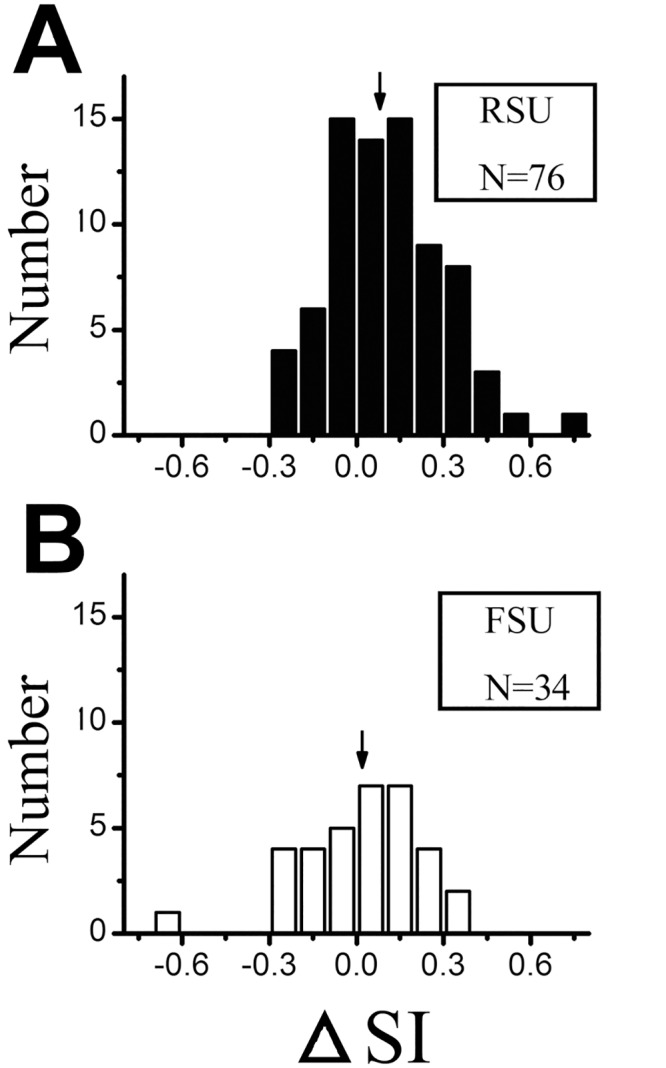
The histogram of changes in strength of surround suppression for FSUs and RSUs.The △SI indicate the difference between SIhigh and SIlow. The arrows indicate the average, which was 0.02 for FSUs and 0.08 for RS-Units (P >0.05).